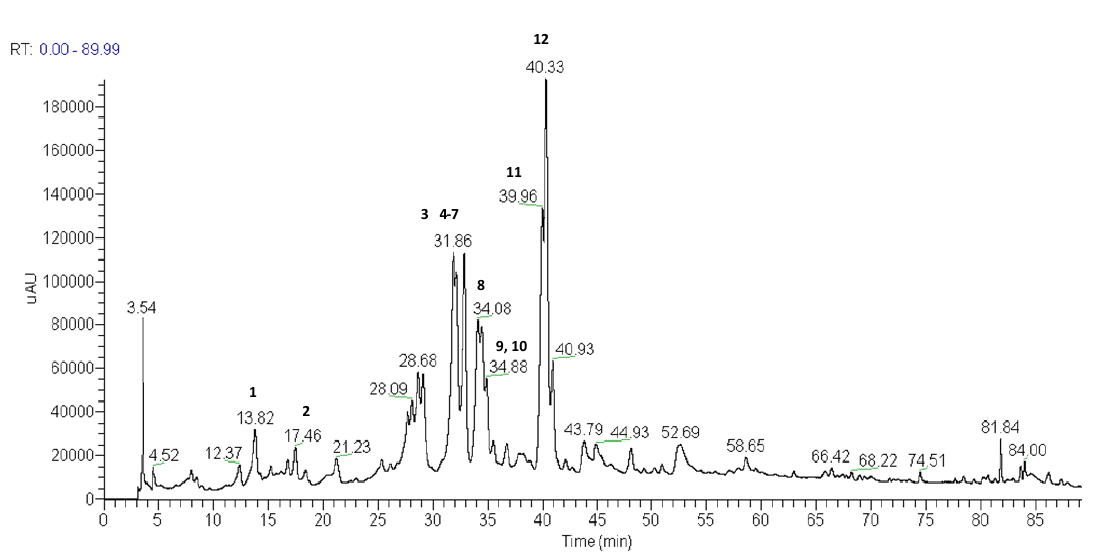
Figure 1. Total ion current chromatogram of the methanol extract of capitulae of P. chiquitensis (HPLC-ESI-IT-MS n negative ion mode). For conditions, see experimental part.